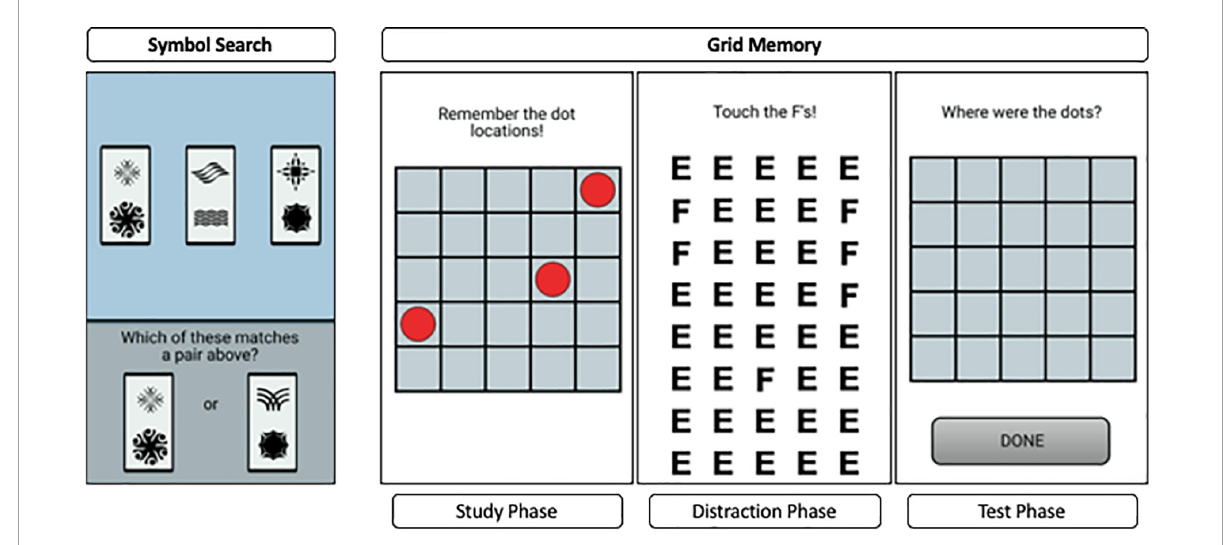
FIGURE3 An example trial from the symbol search task (top) and the grid memory task (bottom)